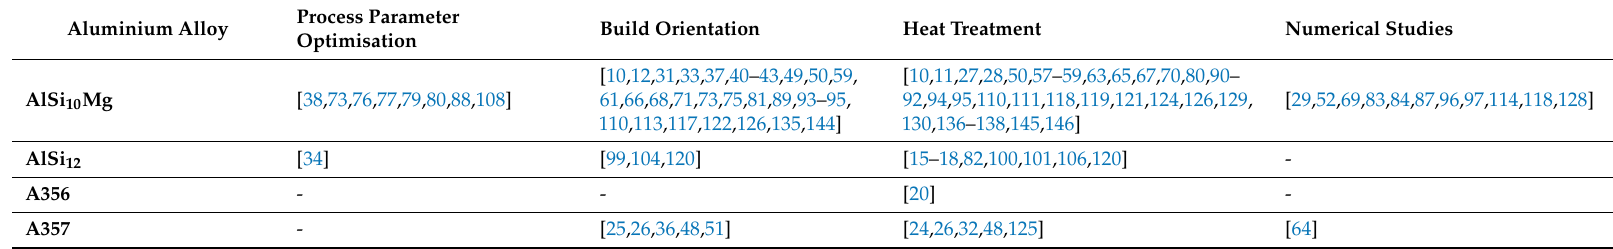
Table 2. Overview of research focus areas into four categories.